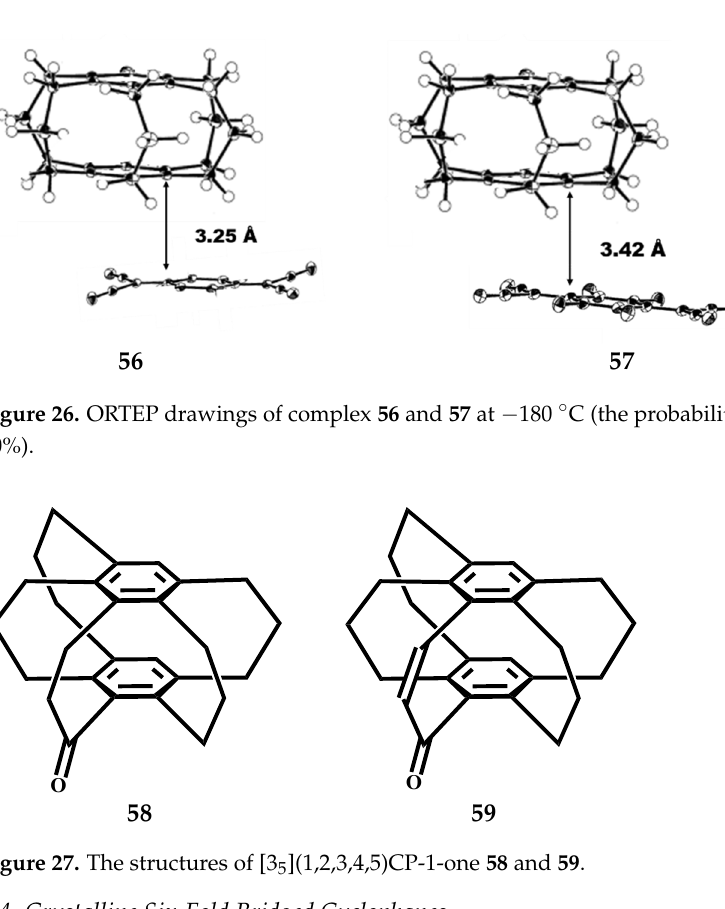
Figure 25. The stable conformers of 55a , 55b and 55c of the [3 5 ]CP 55 .